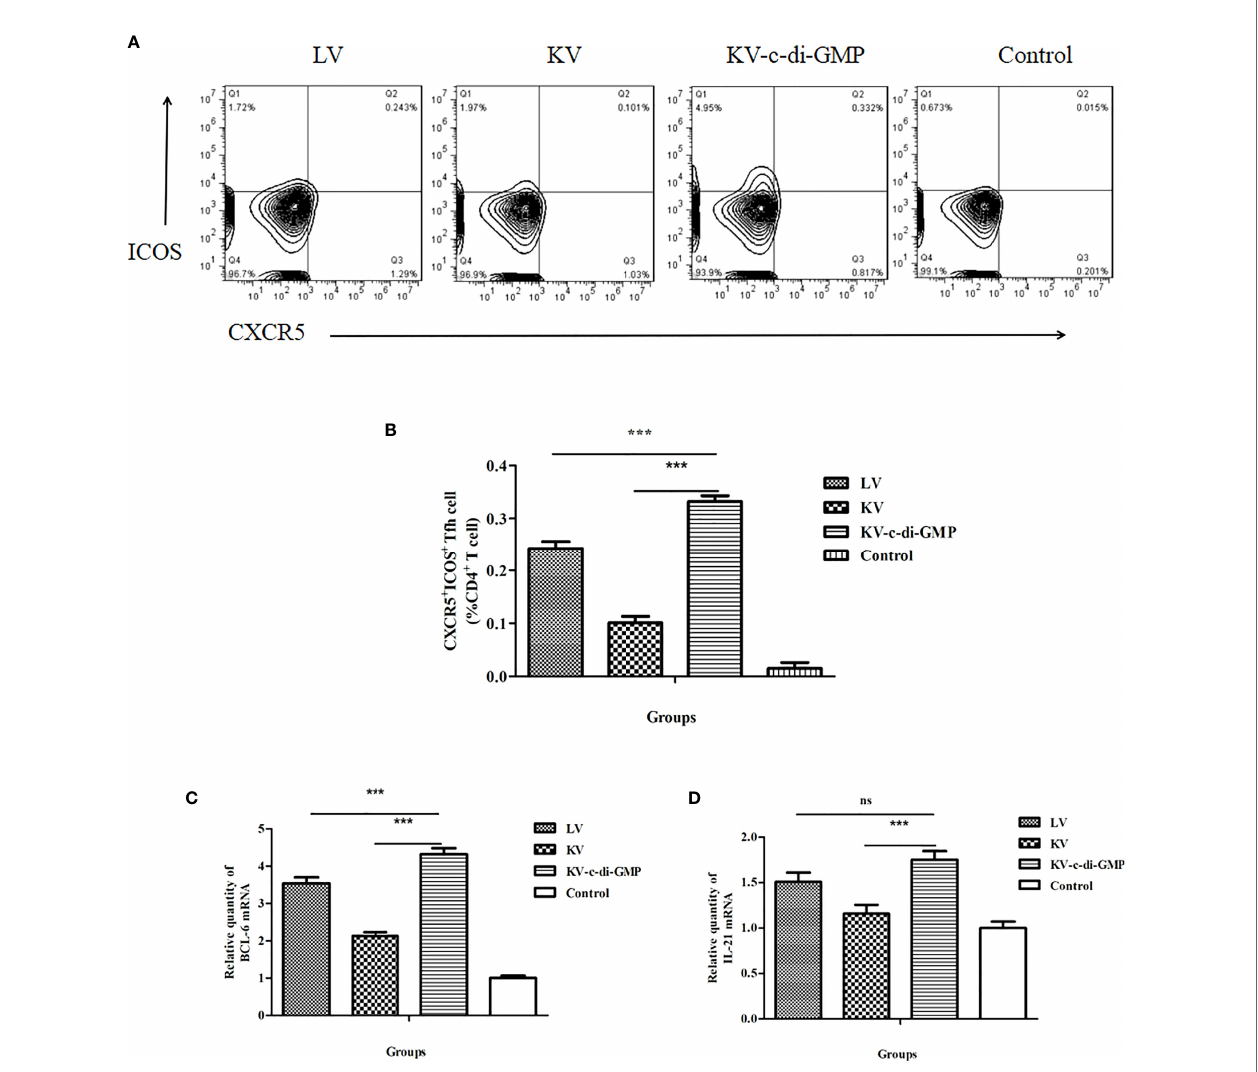
FIGURE 3 | Tfh cell responses in mice induced by the LV, KV, and KV-c-di-GMP vaccines and PBS control at 28 dpi. (A) FACS analysis of CXCR5 + ICOS + Tfh cells. (B) Mean frequencies ± standard deviation of CXCR5 + ICOS + Tfh cells. Data represent three independent experiments. Pooled LNs from three mice were processed independently three times were analyzed by real-time PCR for (C) Bcl-6 and (D) IL-21 expression. *** P < 0.001; NS, no signi fi cant